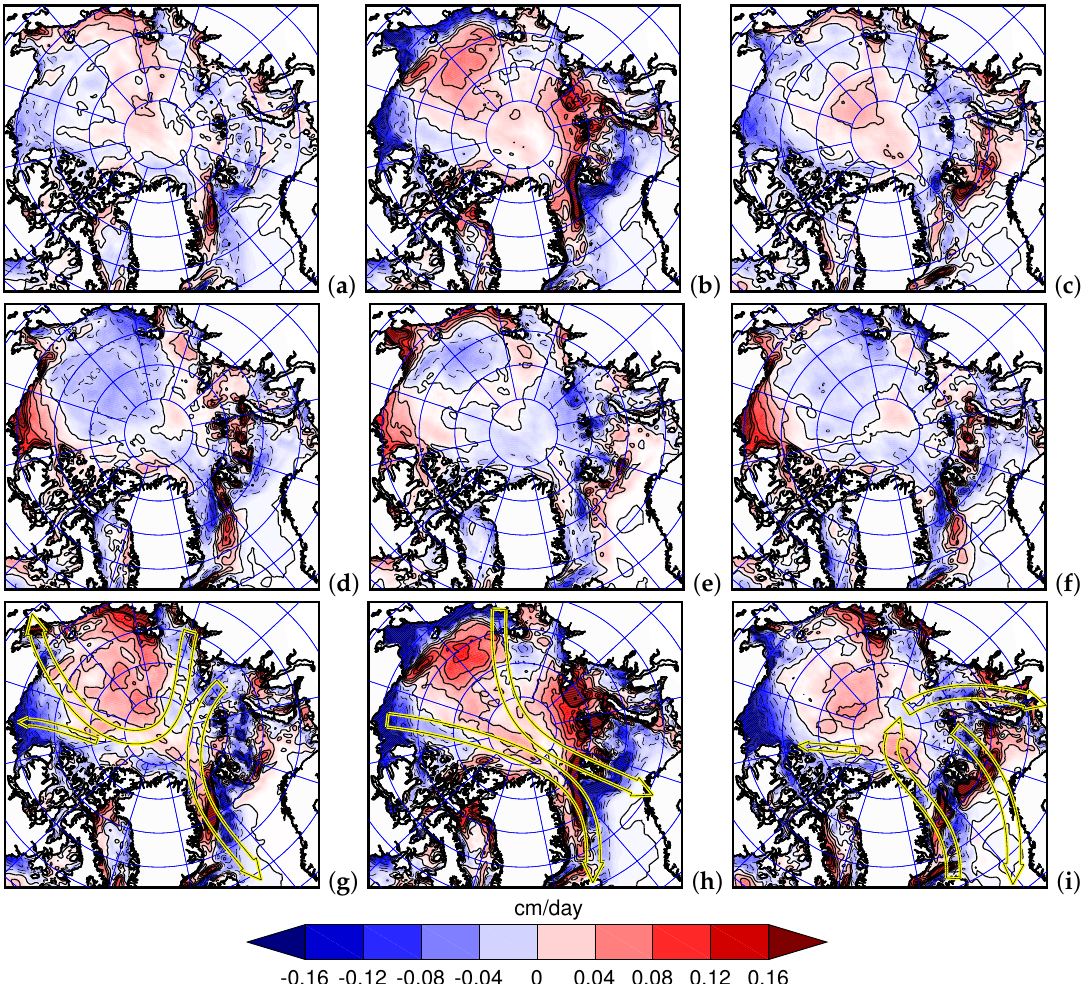
Figure 7. Ice growth rates due to dynamic factors (cm/day) associated with the first ( a , d , g ), second ( b , e , h ) and third ( c , f , i ) EOF modes of the surface wind decomposition: ( a – c ) the weighted average value of the growth rate for the periods of positivity of the principal components of the decomposition, ( d – f ) the weighted average value of the growth rate for the periods of negativity of the principal components, ( g – i ) the difference of the weighted average of the positive and negative phases (( g − − i ) = ( a − − c ) − ( d − − f )) . In the figures ( g – i ), yellow arrows schematically indicate the prevailing surface wind directions corresponding to the positive phases of the circulation